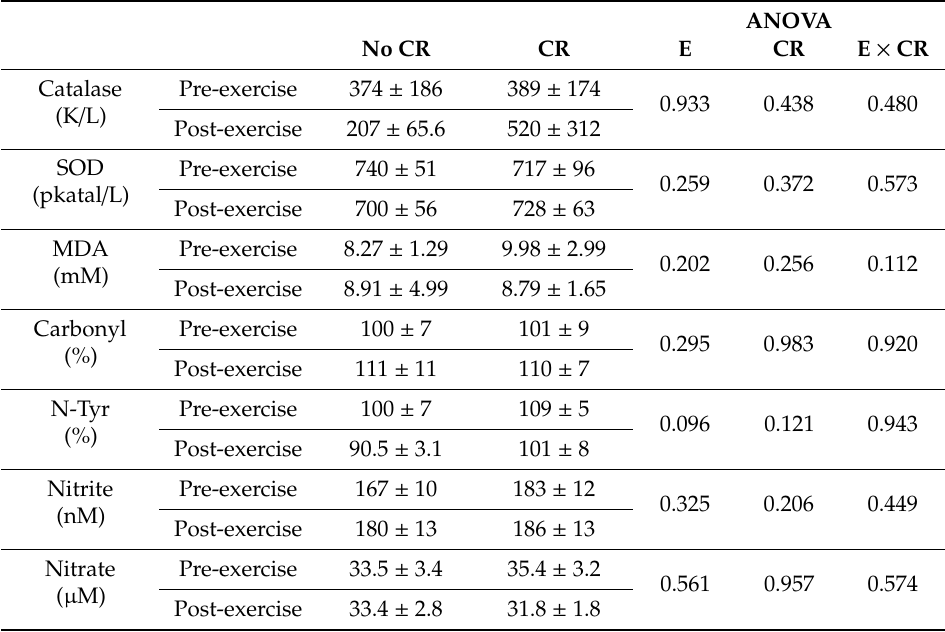
Table 4. E ff ects of a maximal exercise test and calorie restriction intervention on plasma oxidative damage markers and antioxidant